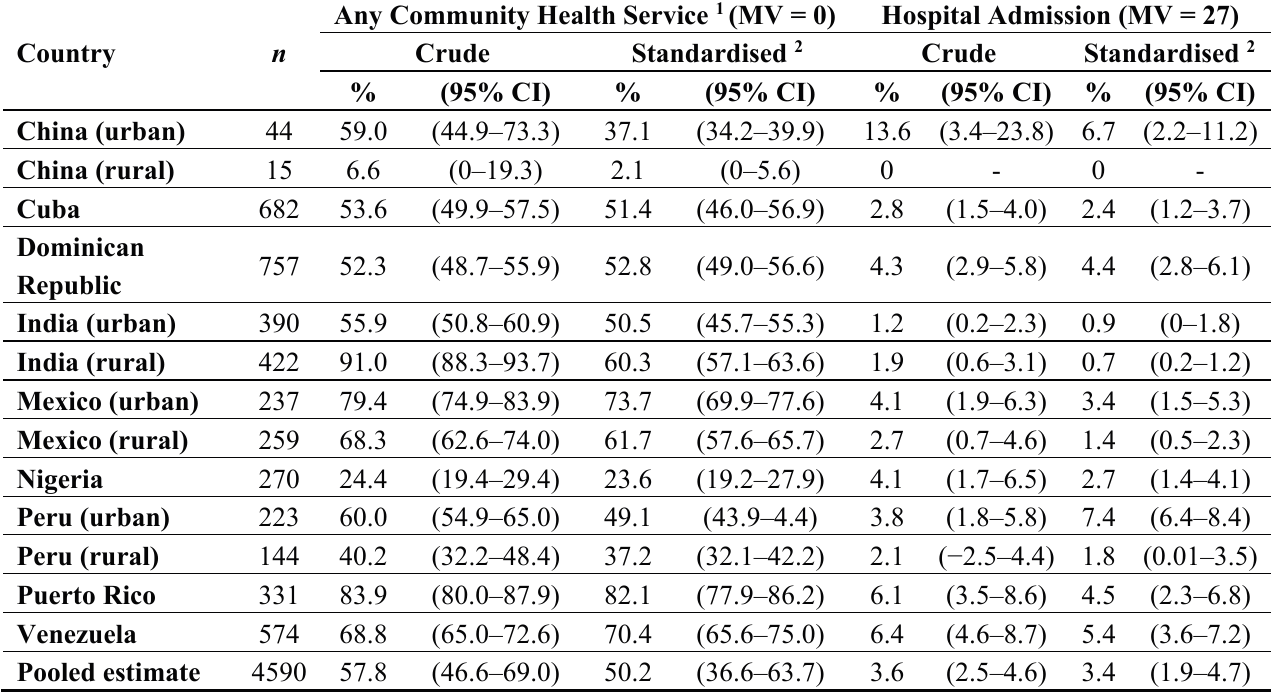
Table 2. Prevalence of previous health service